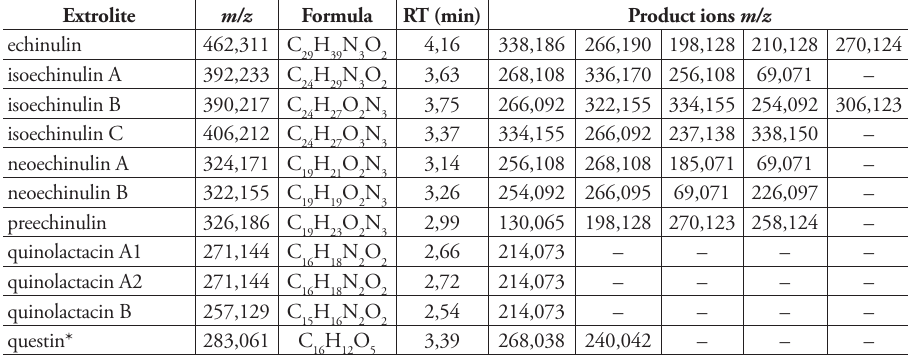
Figure 4. Chemical structure of major compounds produced by A. mallochii and A. megasporus Table 2. Overview of the major extrolites detected and product ions.